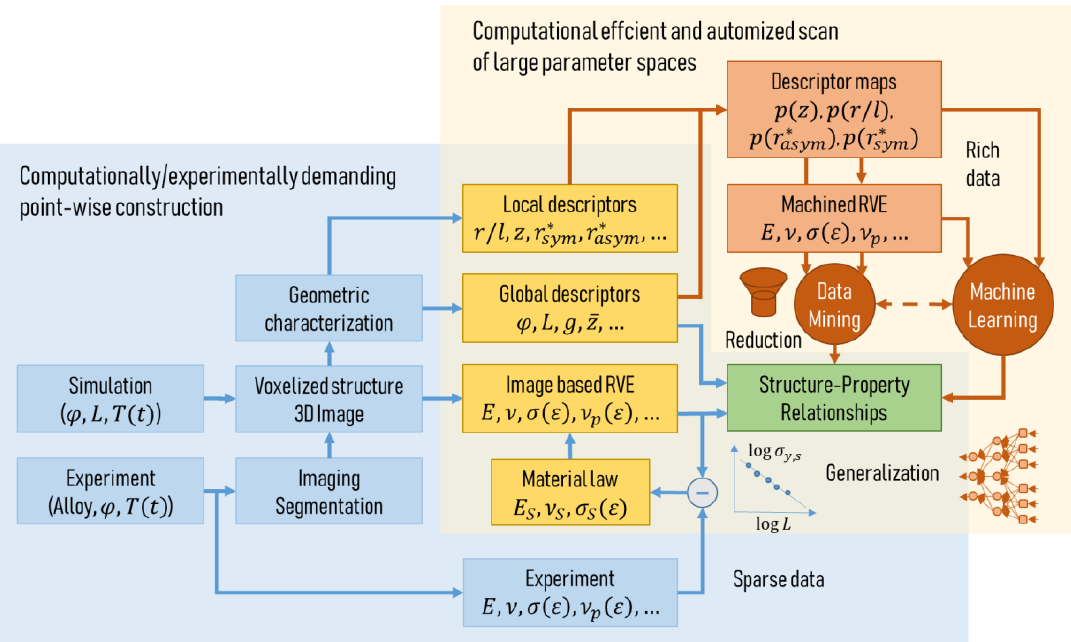
Figure 22. Workflow of the microstructure characterization and micromechanical modeling chain for data generation and identification of the structure–properties relationship of nanoporous metals.